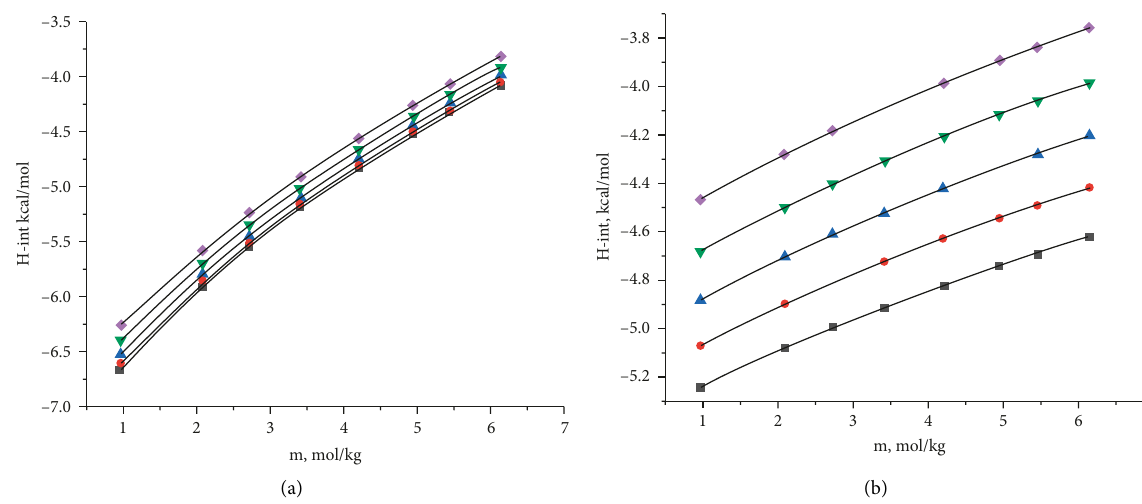
Figure 6: Correlation of the interaction data for the CaCl2+H2O system. (a) The interaction of CaCl2 and (b) the interaction of H2O. Symbols ( , T � 303.15K;